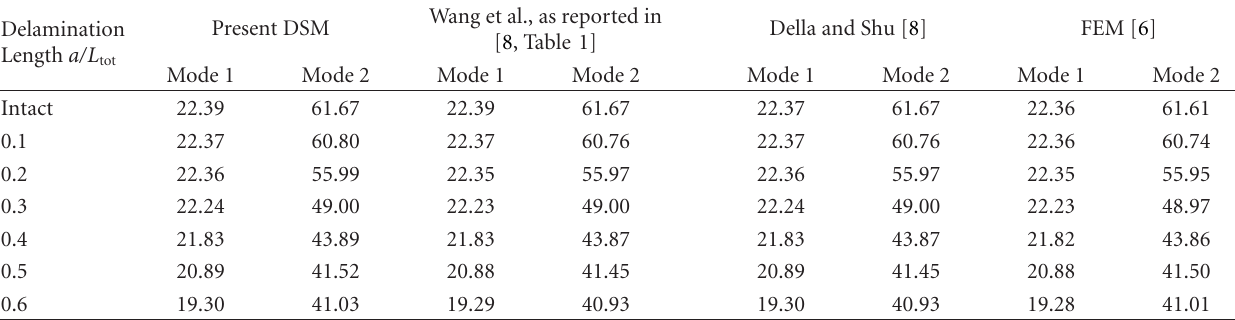
Table 1: Natural frequencies λ 2 of the delaminated beam, with a split occurring symmetrically about the midsection along the midplane [1]; DSM, CM, FD-FEM, and standard FEM